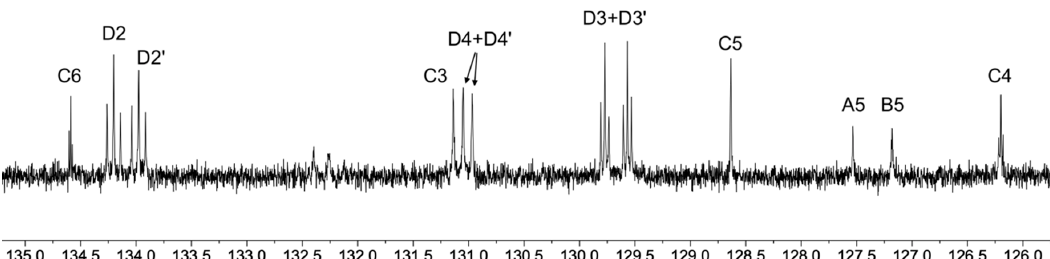
Figure 2. Part of the 13 C{ 1 H} NMR spectrum of [Cu(xantphos)(6-Cl-6’-Mebpy)][PF 6 ] (126 MHz, 298 K, acetone- d 6 ) evidencing the two environments of the PPh 2 phenyl rings (rings D). See Scheme 1 for atom numbering. Scale: δ / ppm.